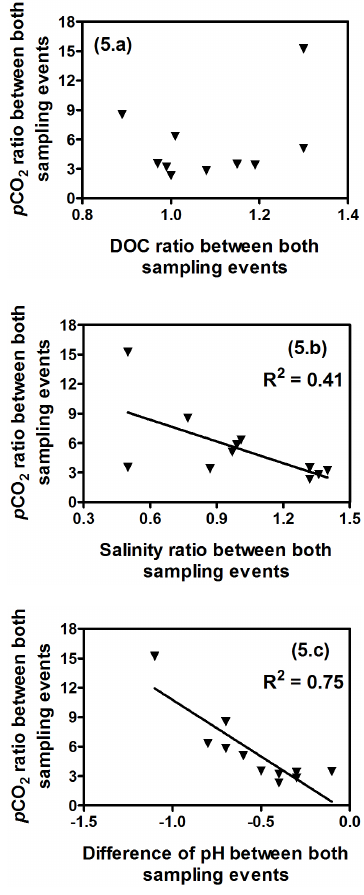
Fig. 5. The relationships of the variation rates, comparing the rainier sampling event to drier one, of p CO 2 with (Fig. 4a) DOC, (Fig. 4b) salinity and (Fig. 4c) pH in the 11 lakes sampled simulta- neously. Solid lines represent the significant fitted regression equa- tions ( p < 0 . 05) for changes in salinity (variation rate in p CO 2 = − 7.4 variation rate in salinity + 12.8, R 2 = 0.41) and pH (variation rate in p CO 2 = − 11.5 variation rate in pH − 0.8, R 2 =